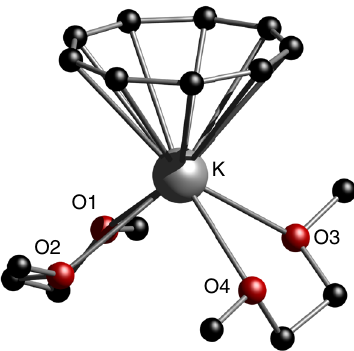
Fig. 2 Molecular solid-state structure of compound 1 . [( η 9 -C 9 H 9 )K(DME) 2 ] 1. Color code: K, gray; C, black; O, red. Hydrogen atoms are omitted for clarity